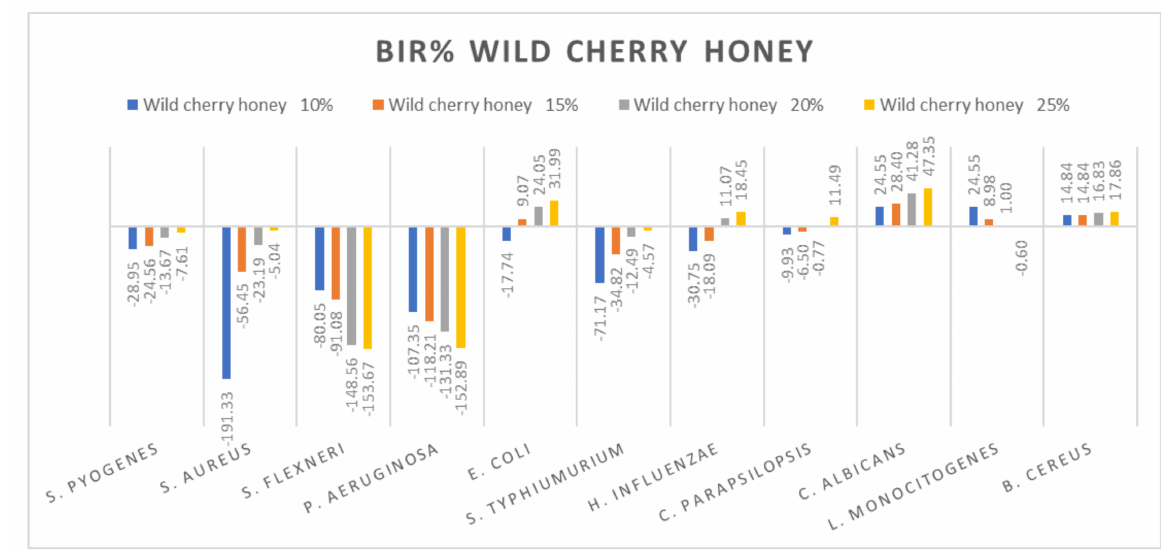
Figure 7. Wild cherry antimicrobial activity (expressed as BIR%/MIR%) on ATCC strains.